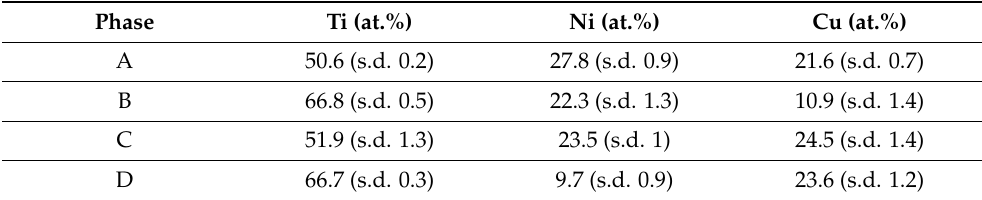
Figure 6. SEM micrographs of TQ and thermally treated samples at high magnification (5000 × ). The labels A, B, C, and D indicate the different phases identified by the EDS analysis. Table 3. Compositions in at.% obtained by means of EDS of the different phases observed through SEM analysis. s.d.: standard